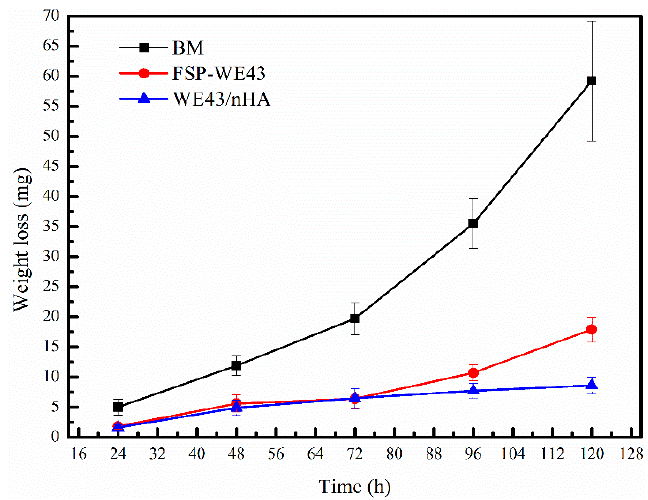
Figure 10. The weight loss and corrosion rate curves of immersion specimens.